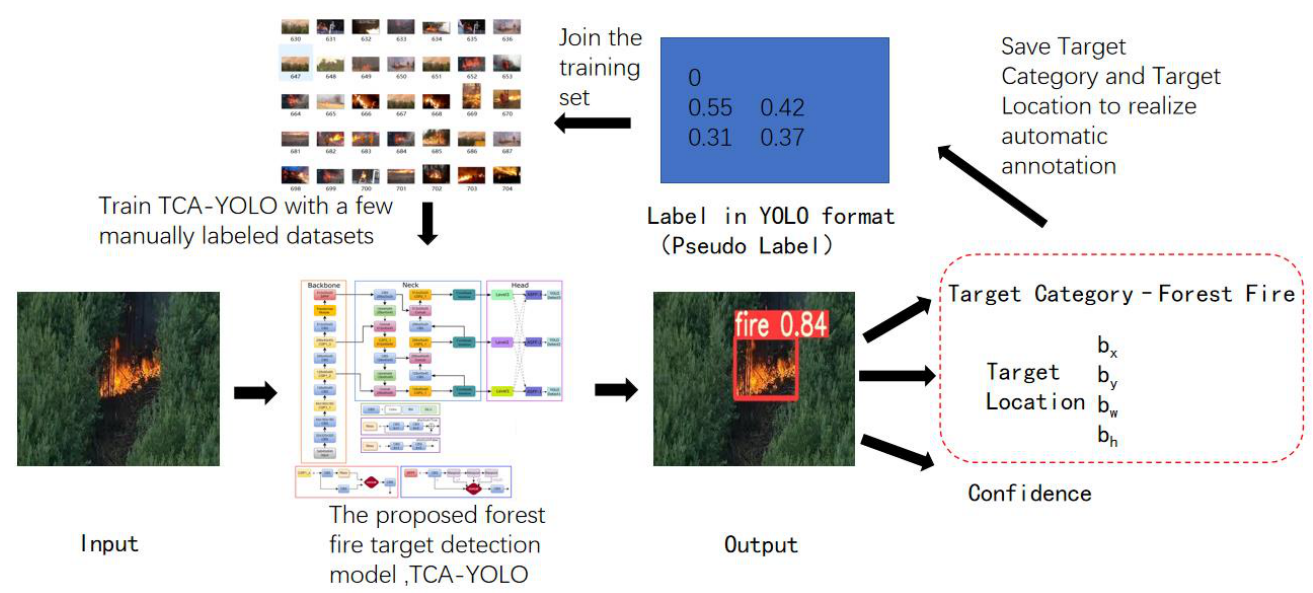
Figure 8. Schematic diagram of automatic annotation of forest fire datasets.